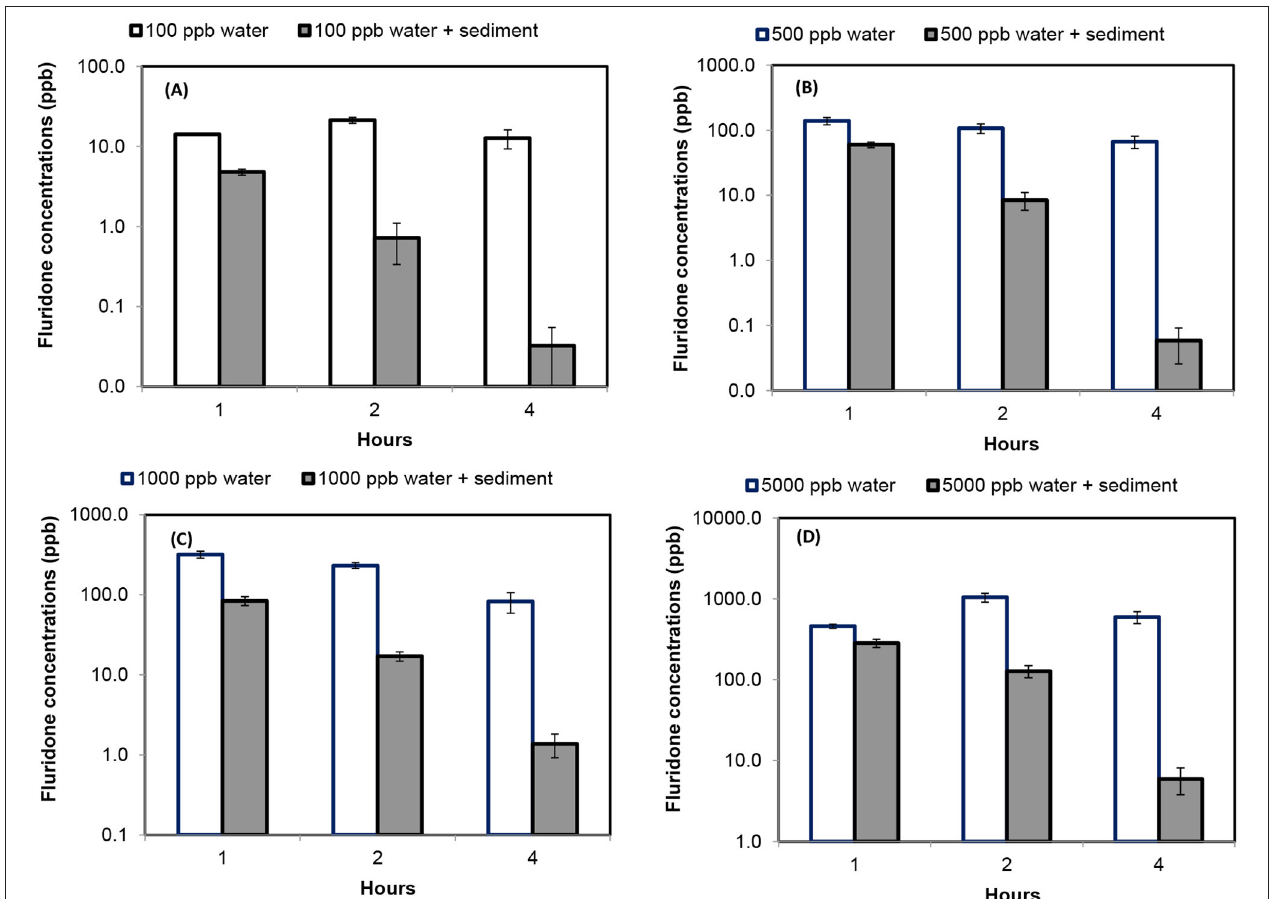
FIGURE 1 | Fluridone concentration determined in water and sediment feedstock after consecutive washes [error bars indicate standard deviation of 3 replicates]. (A) Determination of Fluridone concentrations in water and sediment environment at initial concentrations of 100 ppb; (B) Determination of Fluridone concentrations in water and sediment environment at initial concentrations of 500 ppb; (C) Determination of Fluridone concentrations in water and sediment environment at initial concentrations of 1,000 ppb; and (D) Determination of Fluridone concentrations in water and sediment environment at initial concentrations of 5,000 ppb.